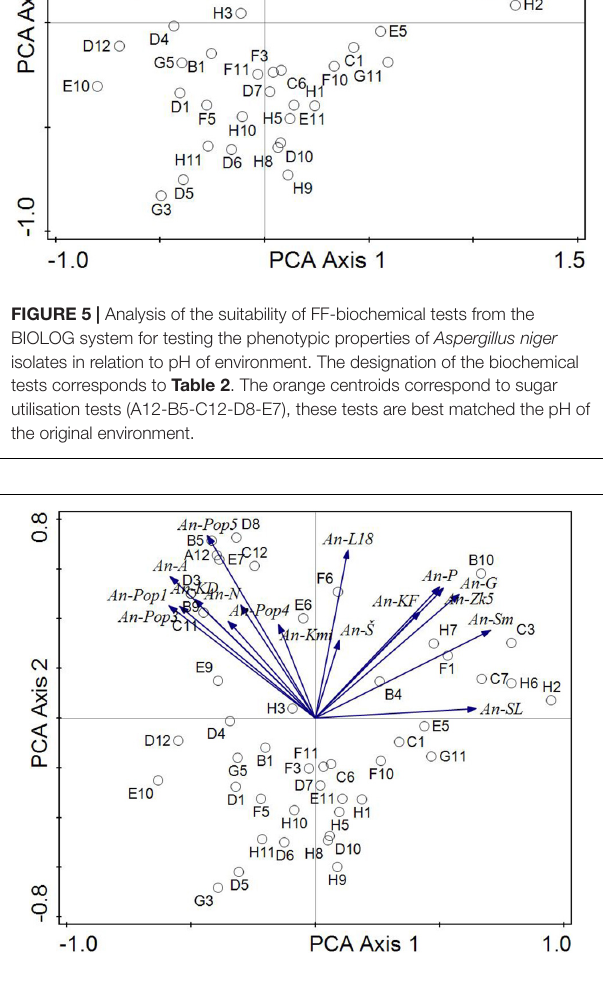
FIGURE 6 | Analysis of biochemical similarity of Aspergillus niger environmental strains in relation to pH values of the environment. The phenotype similarity is expressed by the angle between individual strains (arrows). The correlation between the strains is stronger the sharper the angle between them. Environmental variables are shown like centroides. Direction of the arrow corresponds to the steepest increase in the covariance of Aspergillus niger strains and environmental